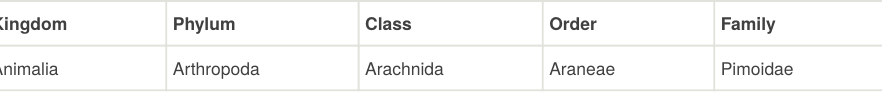
Map of records (Google